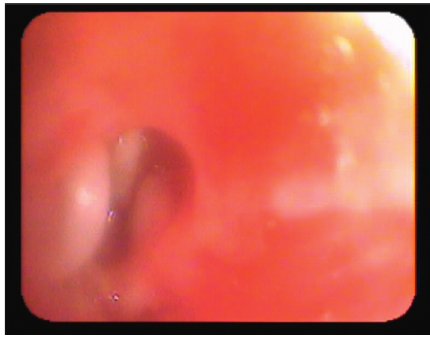
Figure 3: A still frame from the bronchoscopy, showing the foreign material in the left main bronchus.